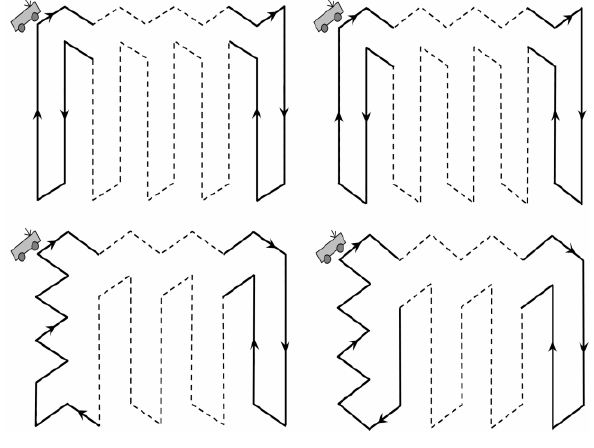
Figure 3. Different moving paths in [23].